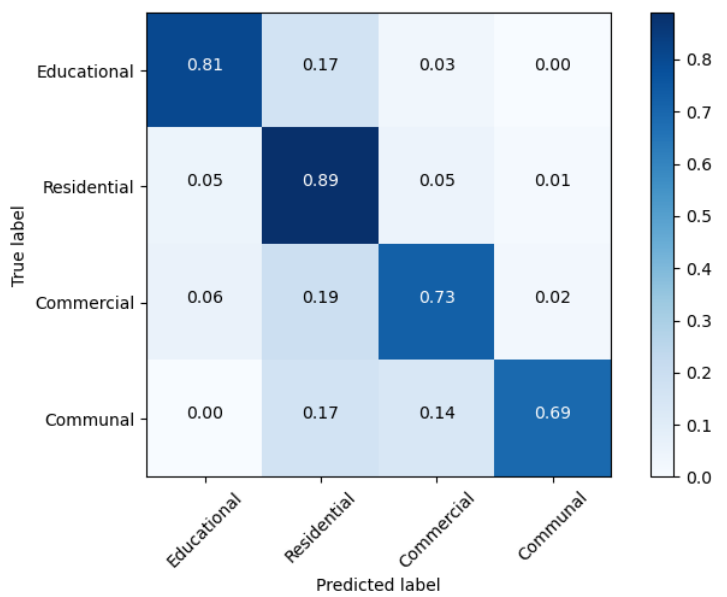
Figure 6. The confusion matrix for the classification results of UniMP on the classification of the building function.